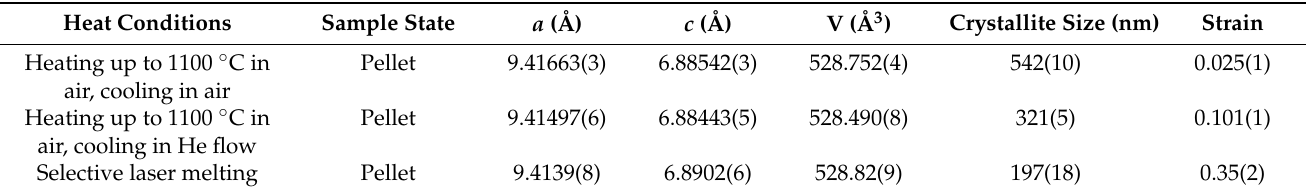
Figure 6. Variation of the lattice parameters ( a , b ) and volume ( c ) as a function of temperature for the HA pellet at in situ experiment. Table 4. Structural parameters for the HA phase treated under various conditions in in situ experiments. The data are given for the sample cooled at room